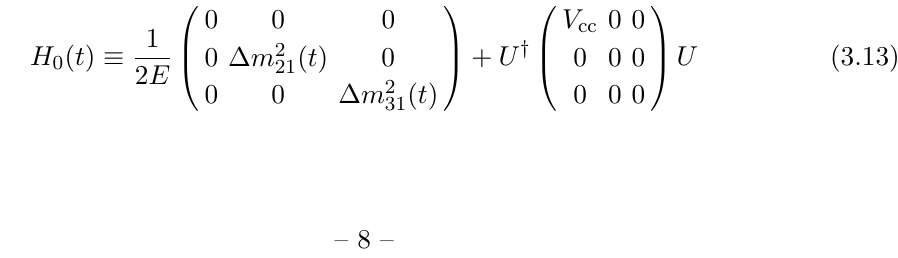
Figure 3 . Averaged ν µ disappearance probability at DUNE for a modulating ∆ m 2 different values of η and in the absence of DiNOs ( η =